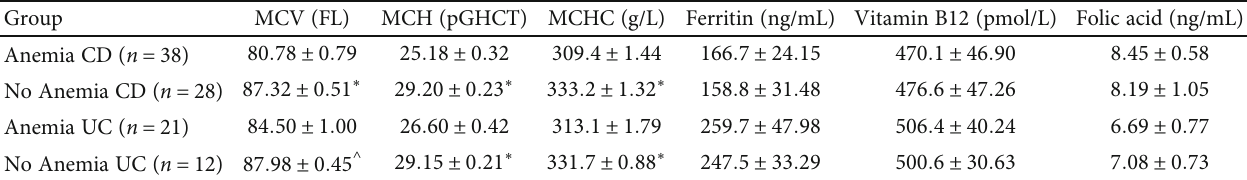
Table 3: Prevalence of MCV, MCH, MCHC, ferritin, vitamin B12, and folic acid in IBD patients. Group